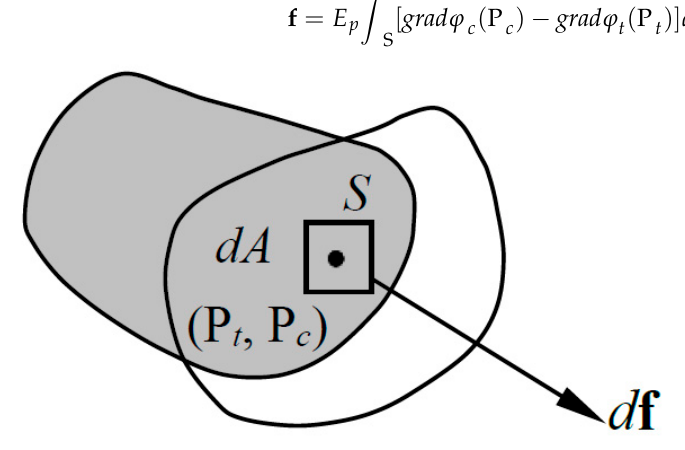
Figure 2. Contact force evaluation in the FDEM.